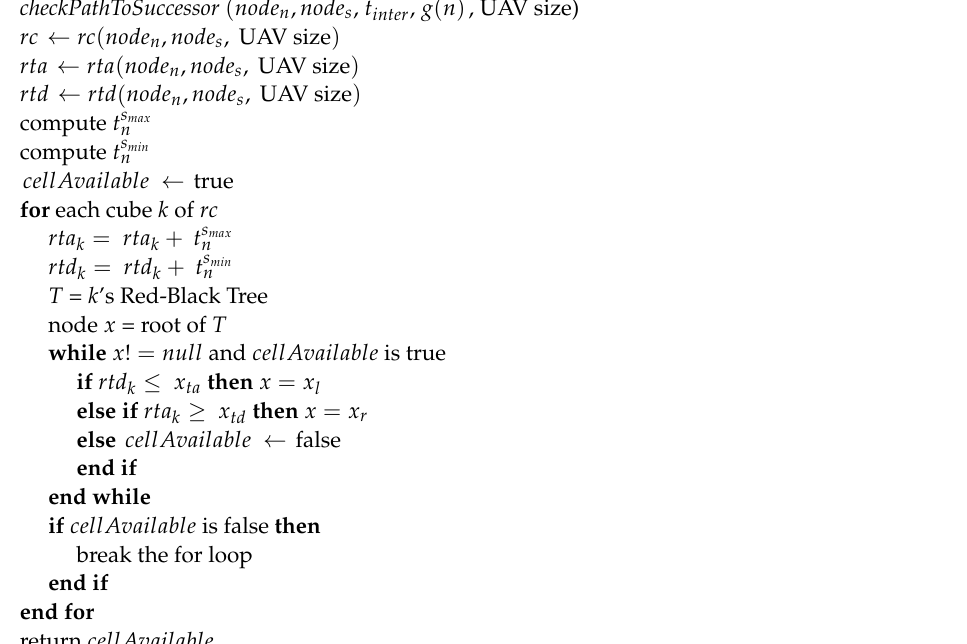
Algorithm 3 Checking if the cubes the UAV will occupy from node n to node s do not conflict with other